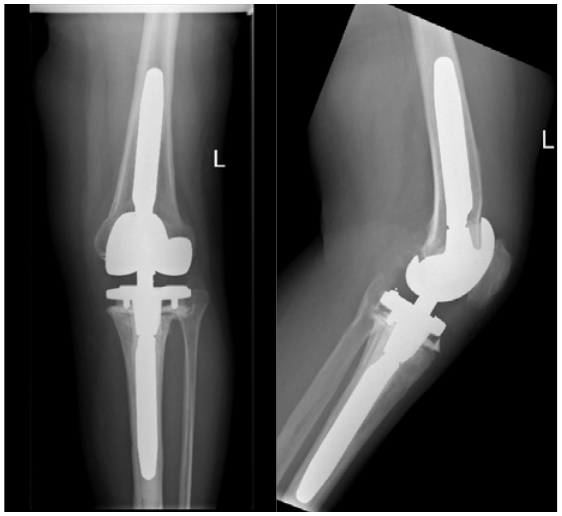
Figure 2. Patient 2, 2 months